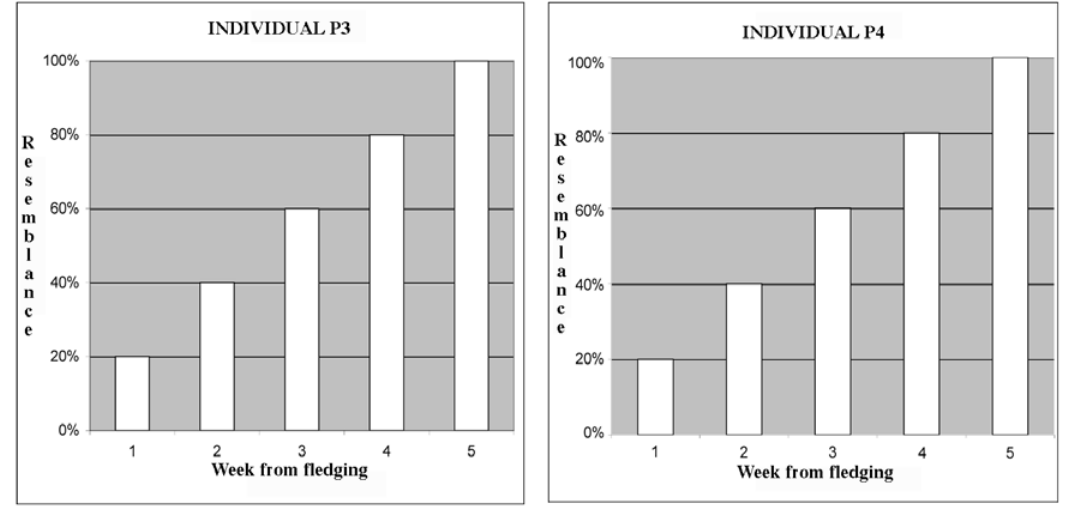
Fig. 4 – Second season chicks subsongs similarity percentage with father themes, from fledging to complete